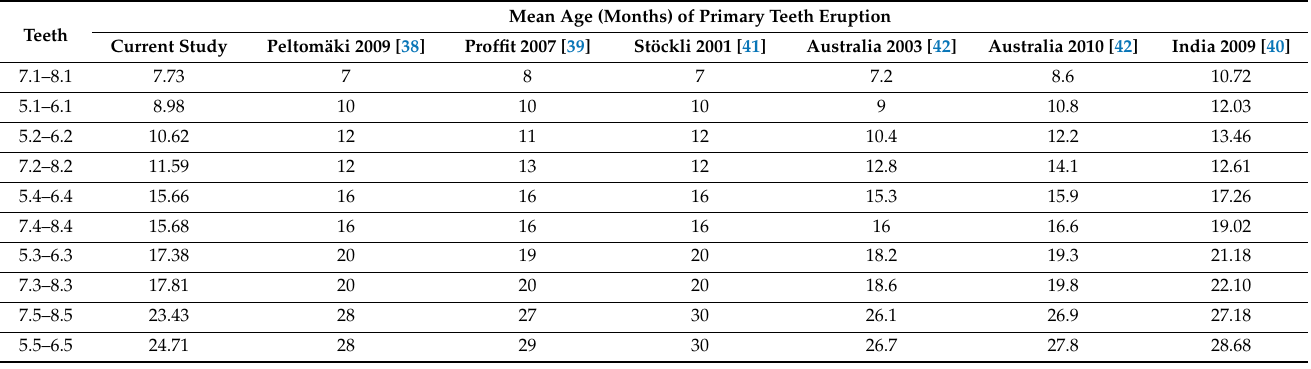
Table 6. Comparison of the results obtained with standard values, presented in the pedodontics- orthodontics treatises and results of other studies [38–42].